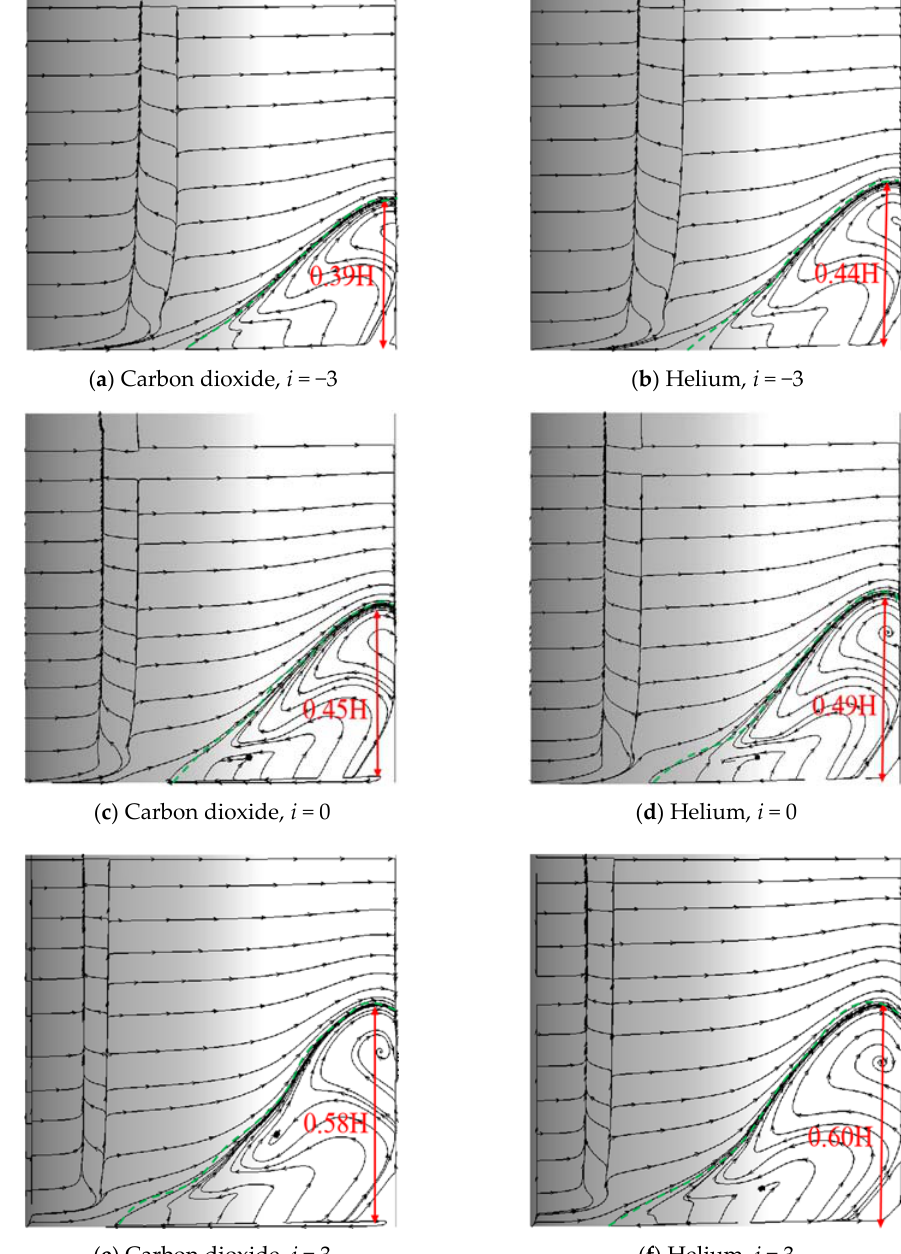
Figure 12. Representations of suction surface skin-friction lines under different attack angle (Ma =